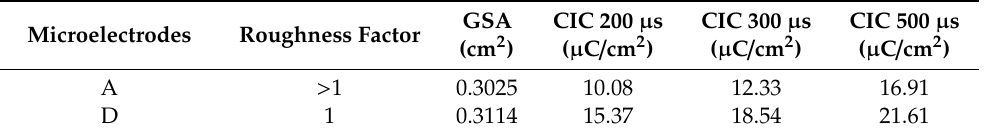
Table 2. Comparison of the CIC of electrodes A and D with similar dimensions, but di ff erent roughness